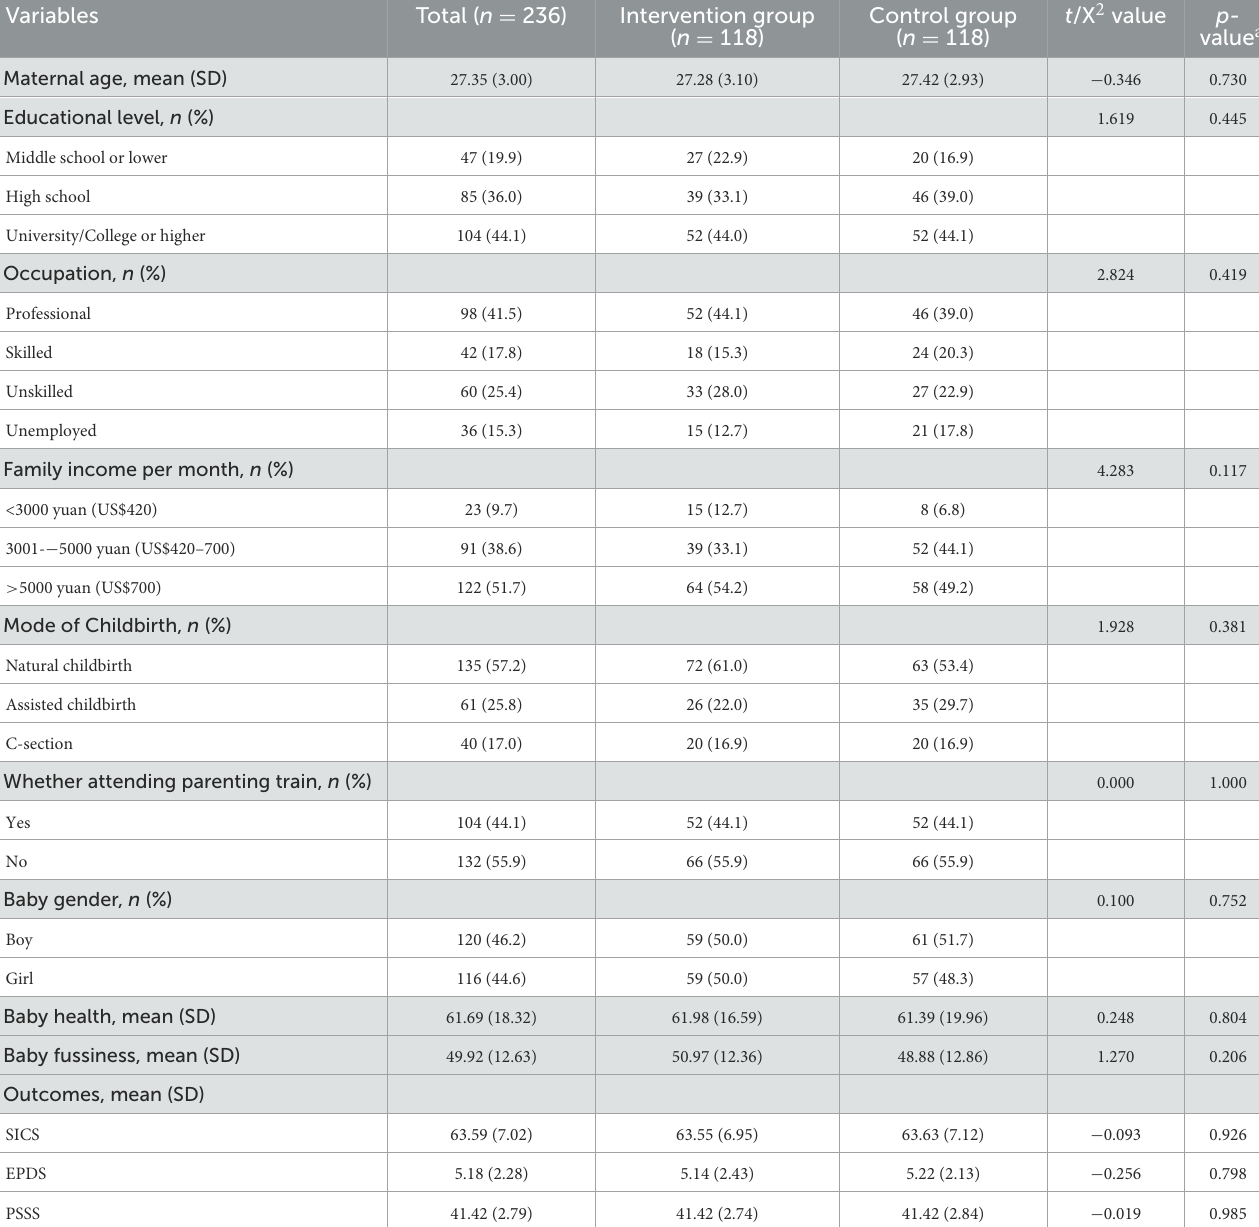
TABLE 1 Comparison of socio-demographic and clinical characteristics and baseline outcomes between the groups. Variables Total ( n =